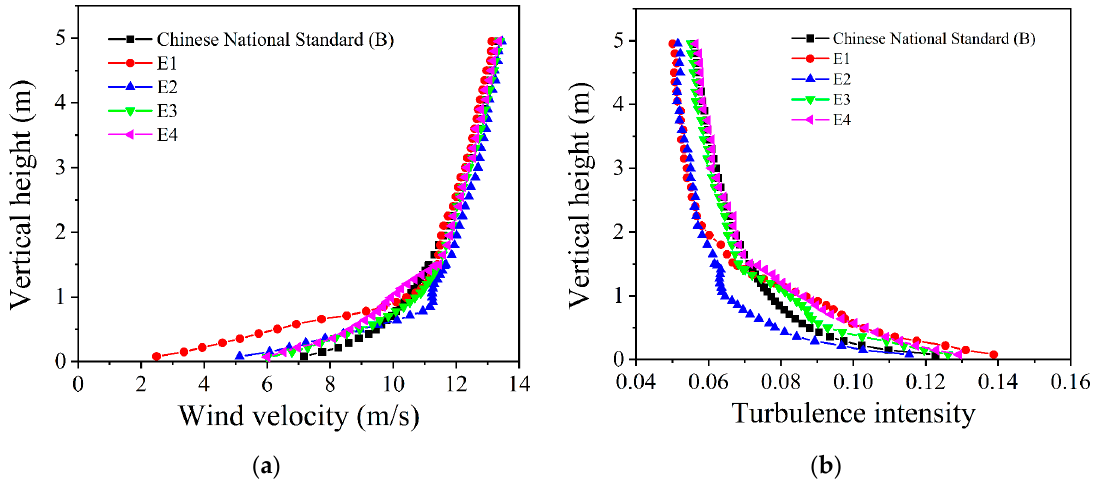
Figure 8. Influences of different FLUENT solution methods on wind field simulation: ( a ) Wind velocity profile; ( b ) Turbulence intensity profile.